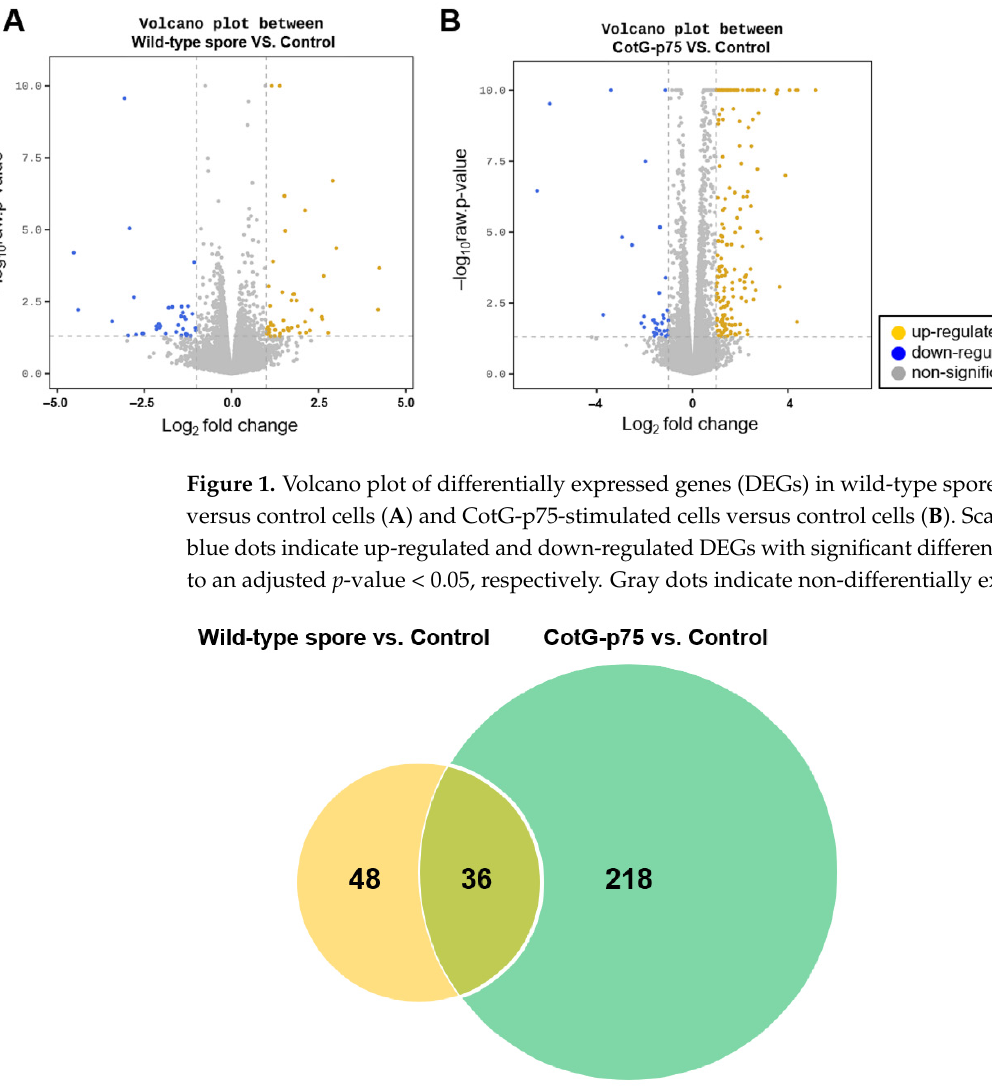
Figure 2. Numbers of common and unique differentially expressed genes (DEGs) in Caco-2 cells treated with wild-type spores and CotG-p75 compared to control. The overlapping region indicates the number of DEGs expressed commonly in two groups. The non-overlapping regions indicate the number of DEGs expressed only in comparison groups.